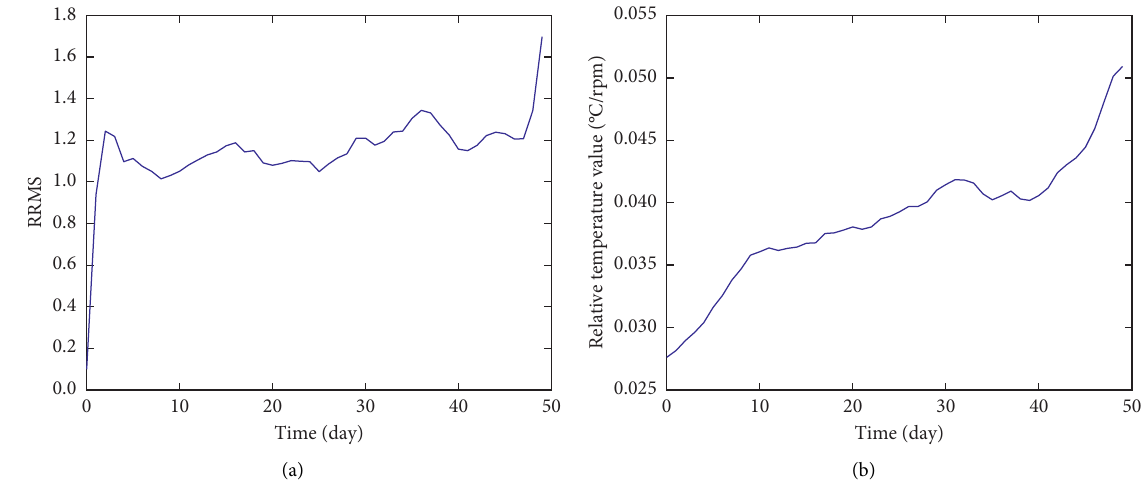
Figure 10: Vibration and temperature feature of the HSS bearing. (a) Vibration feature, (b) temperature feature.